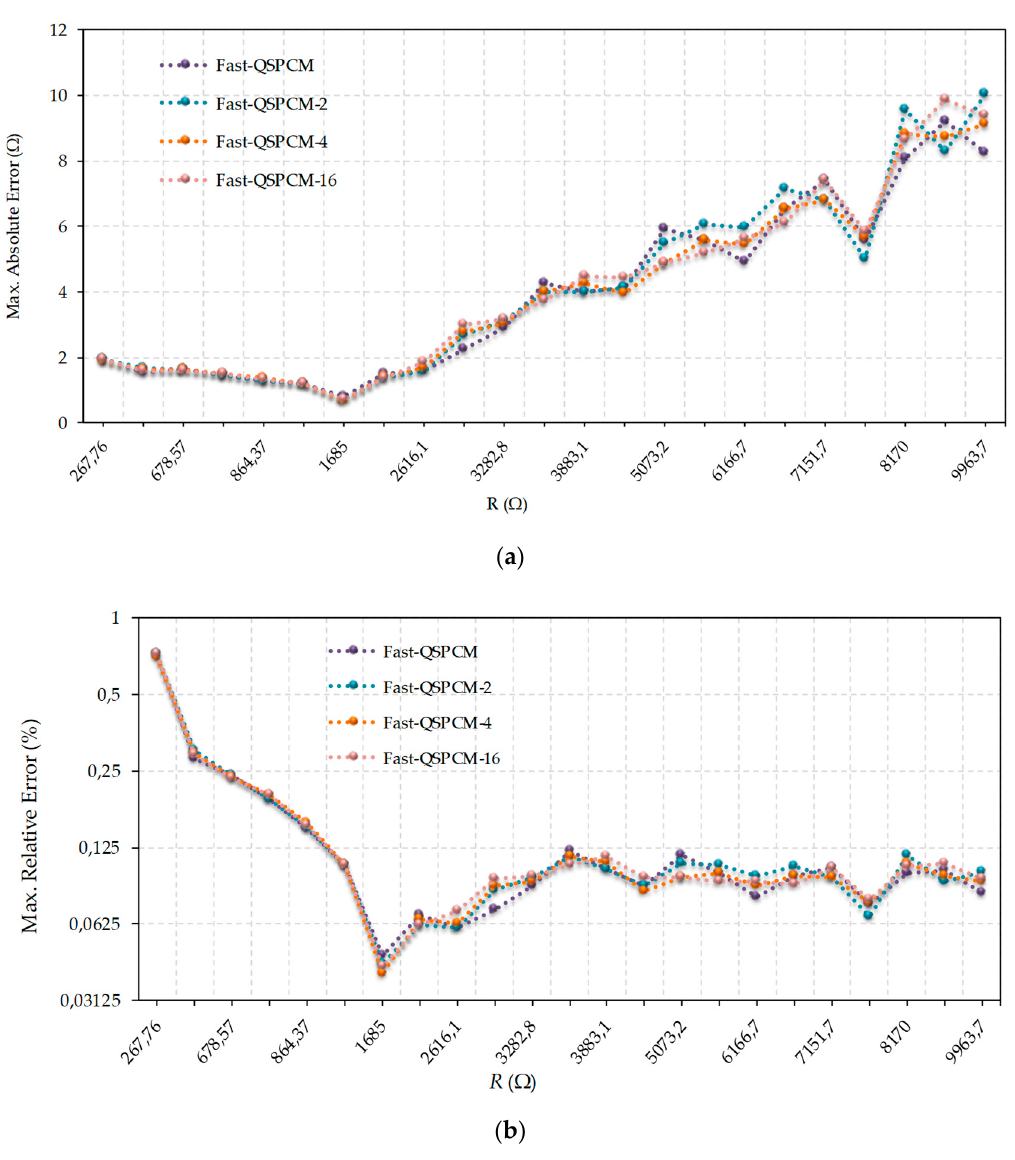
Figure 5. Comparison of errors made in estimating resistance values using Fast-QSPCM and different values of j in Fast-QSPCM- j : ( a ) absolute maximum errors (linear scale); ( b ) relative maximum errors (log2 scale).